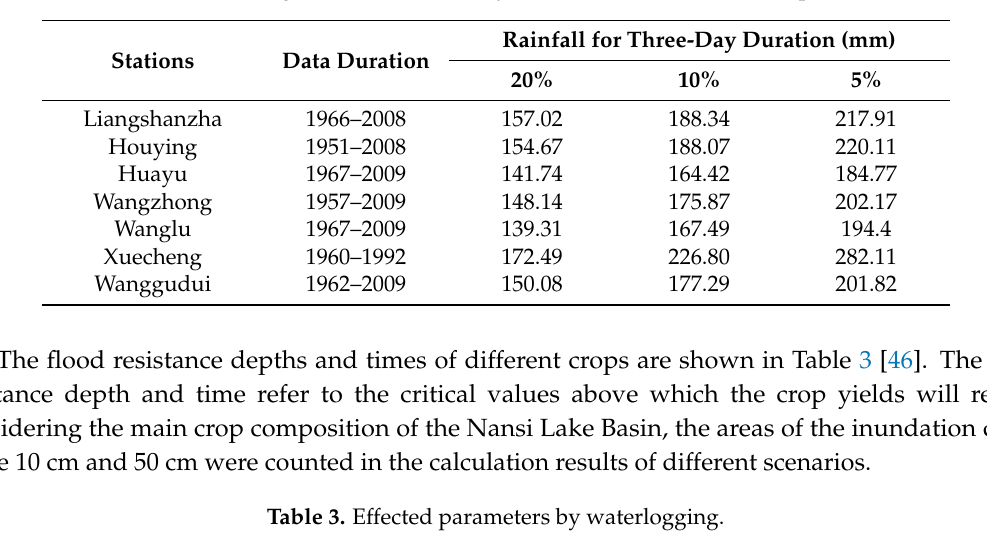
Table 2. The design rainfall of three-day duration for different return periods.